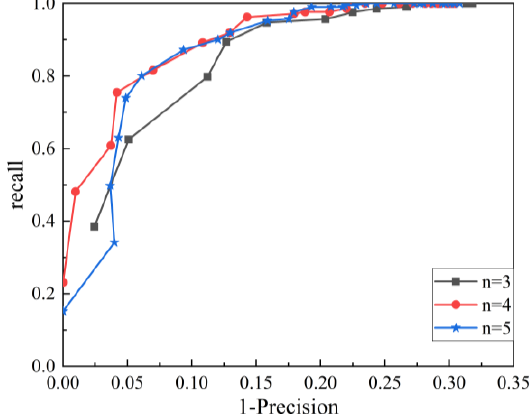
Figure 7. RP curves of different sampling layers.